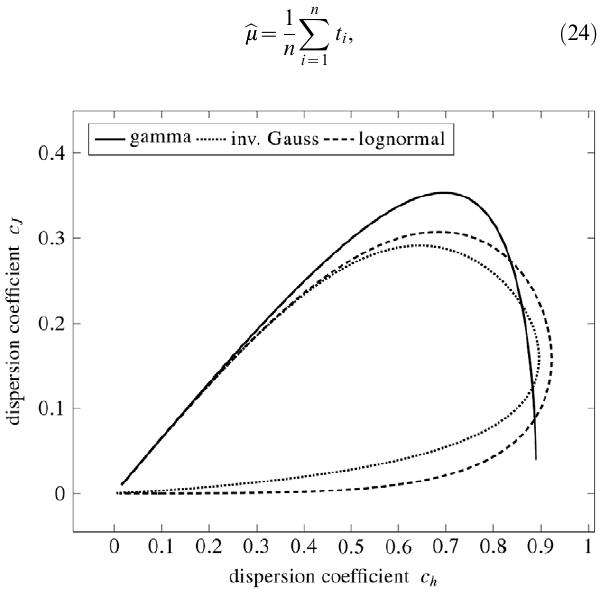
Figure 5. The dispersion coefficients c h and c J for the same distributions as in Figs. 3 and 4. The plot of dependencies between the two dispersion coefficients form closed curve for both inverse Gaussian and lognormal distribution. Starting from the origin and moving clockwise, the points on the loop correspond to the values of c v growing from 0 to infinity. For gamma distribution, c J is a common p : unimodal function of c h . 0 : 707 . ¼